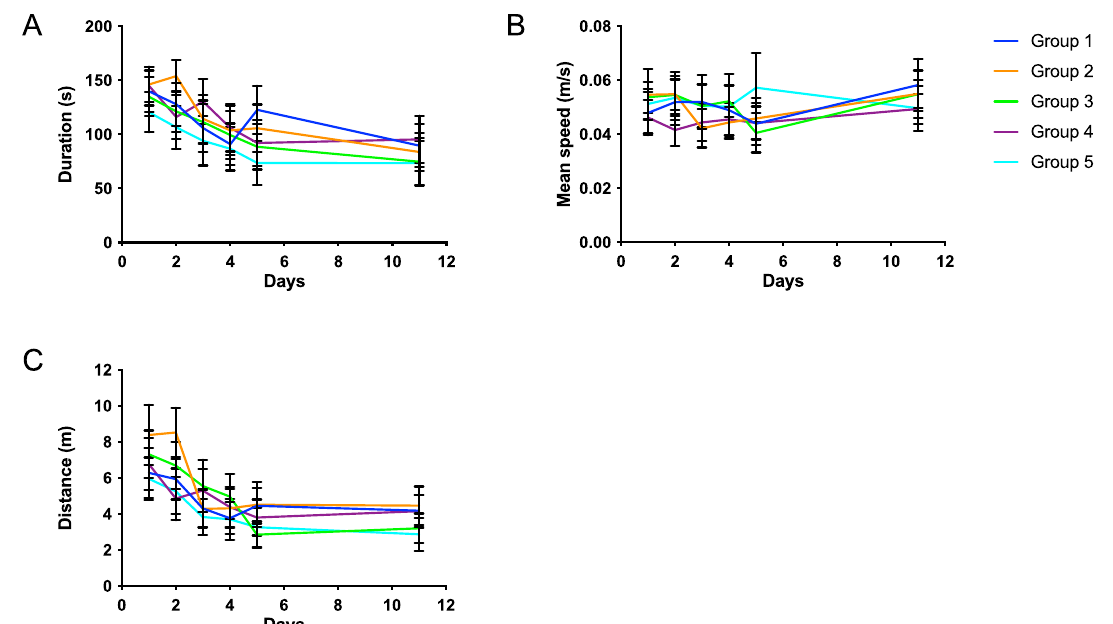
Fig 8. Barnes maze. A: Progression of test mean duration before the task completion (maximum duration 180 sec) with error bars indicating standard deviation, significant differences from G3 were found for the following: G2, day 1(p = 0.009) and G1, day 4 (p = 0.036). B: Test mean speeds of animals, ( ± SD); G3 had significantly higher speed at day 1 compared to G4, (p = 0.002) and significantly slower speed at day 4 compared to G5, (p = 0.026)). C: Mean distance ( ± SD) travelled by the animals during testing; G2 had significantly longer distance at day 1 compared to G3 (p = 0.049), and G3 had significant longer distance, at day 4 compared to G1 (p = 0.010), and G2 (p = 0.019). Group 1–5 represent G1(N-CGMP), G2 (N-CGMP-LNAA), G3 (N), G4 (CGMP-EAA-LP) and G5